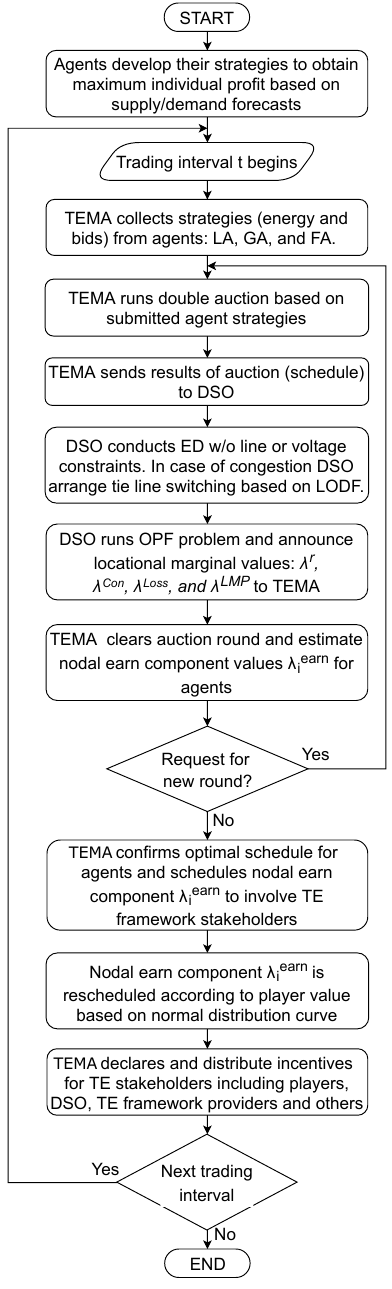
Figure 6. Flow Chart for entire